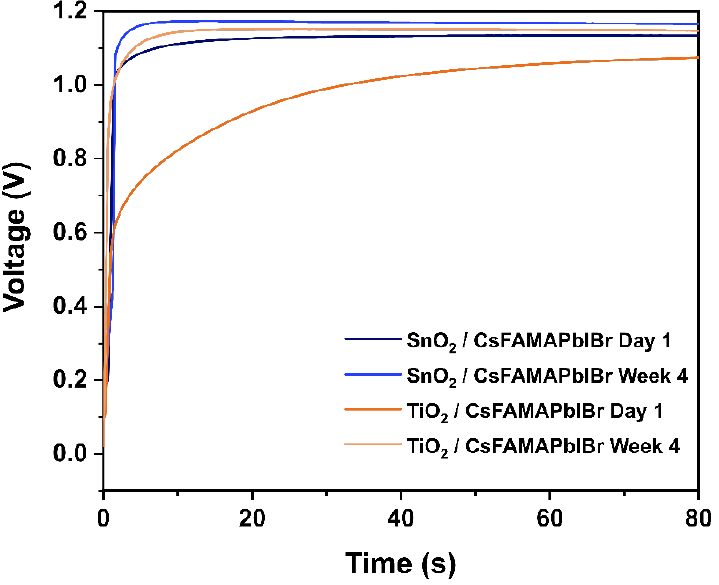
Figure 2. ( A ) Carrier lifetime obtained from TPV decays as a function of the carrier density after the subtraction of the geometric capacitance. ( B ) Carrier density obtained from the integration of the capacitance and after the subtraction of the geometric capacitance. The orange circles represent the TiO 2 /CsFAMAPbIBr, and blue diamonds represent the SnO 2 /CsFAMAPbIBr. In both cases, the filled symbols represent the fresh samples and the empty symbols — the samples after the aging treatment.